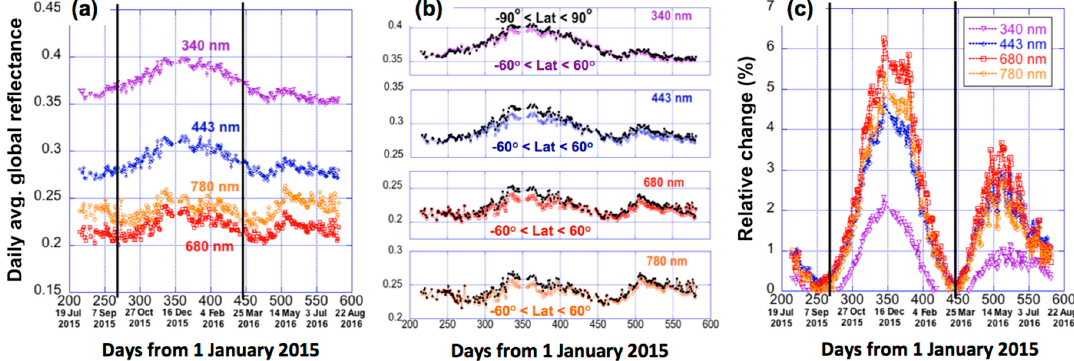
Figure 3. Time-series of daily average global reflectance at different wavelengths. ( a ) Results obtained without polar regions (between 60 ◦ N and 60 ◦ S); ( b ) channel-by-channel comparisons between results including and excluding polar regions; ( c ) relative impact of polar regions on daily average global reflectance. The two vertical black lines represent the two equinox dates of 23 September 2015 and 20 March 2016.